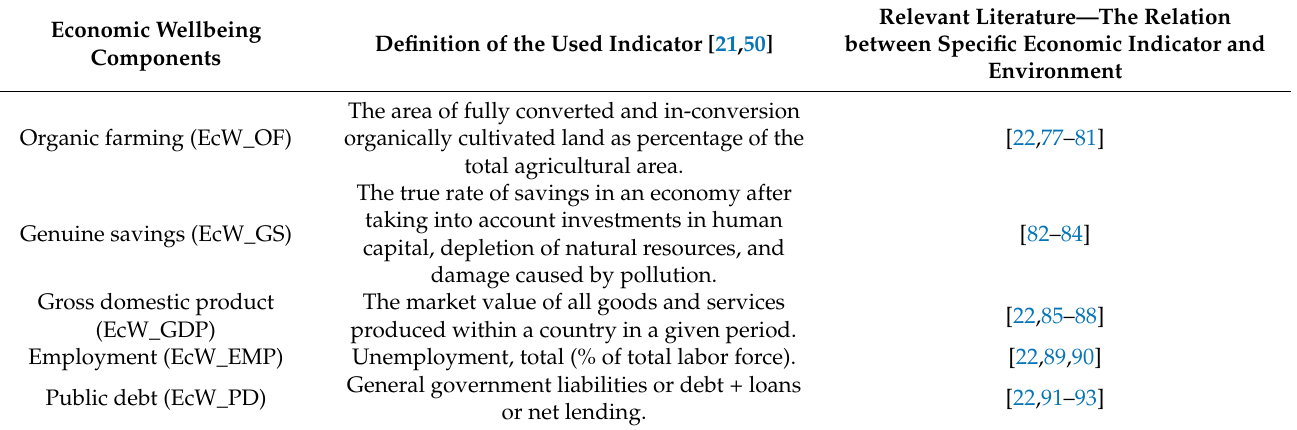
Table 3. Definition of economic wellbeing’s